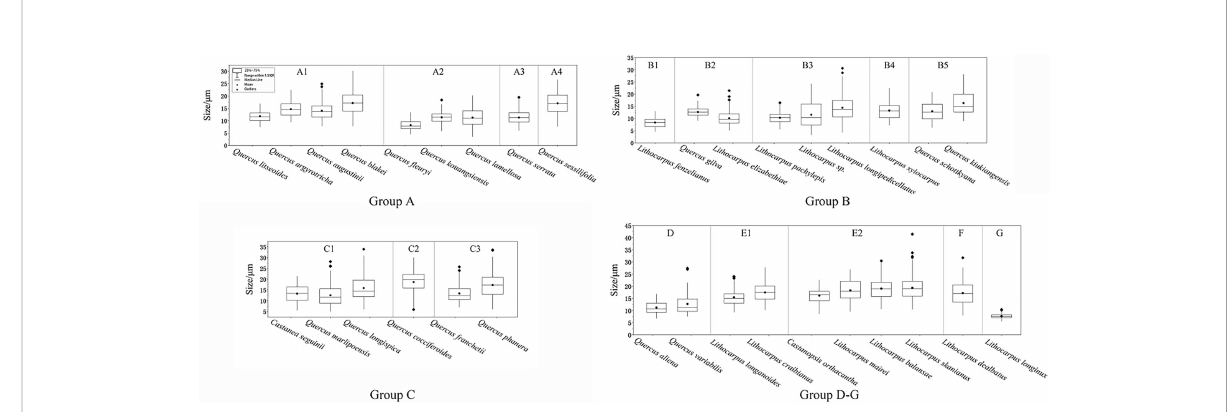
FIGURE 3 Box plot of the granule sizes of the starches